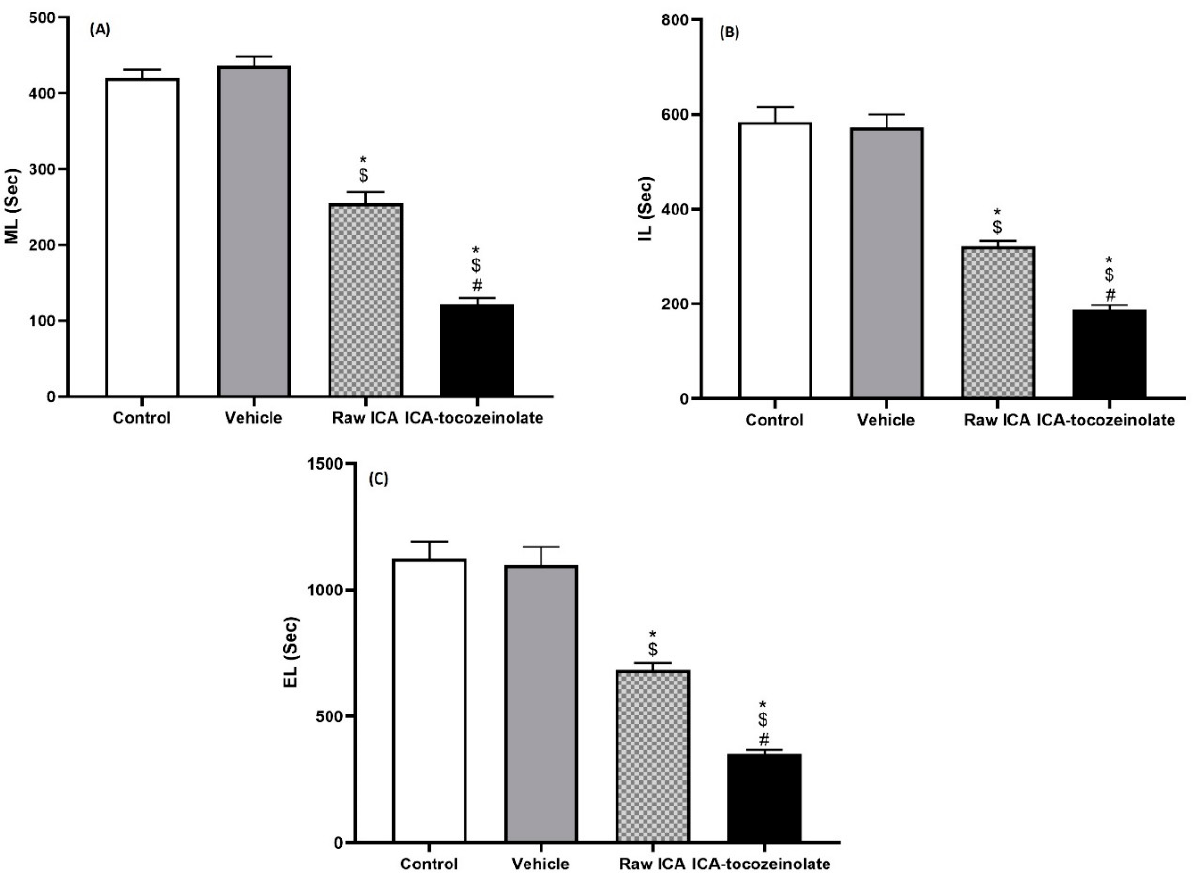
Figure 10. Effect of optimized ICA–tocozeinolate on ( A ) ML, ( B ) IL and ( C ) EL. ML = mount latency = time (in seconds) from the introduction of the female to the first mount. IL = intromission latency = time (in seconds) from introduction of the female to the first intromission (vaginal penetration). EL = ejaculation latency = time (in seconds) from the first intromission to ejaculation. * Significant vs. control; $ significant vs vehicle treated control; # Significant vs. ICA.